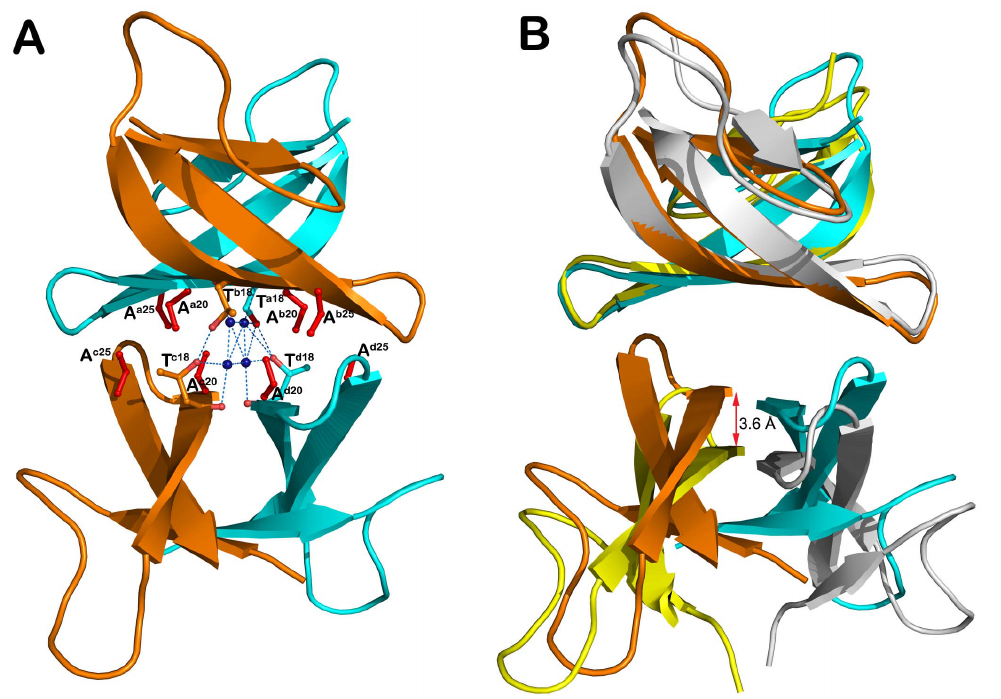
water-mediated H-bonds formed at the tetramer interface is shown as blue dashes. (B) Comparison of Y16A/I20A/L25A/F28A-HNP1 and wild type HNP1 tetramers. Tetramers were aligned based on AB dimers and colored cyan and orange (Y16A/I20A/L25A/F28A-HNP1) and yellow and grey (HNP1, PDB:3GNY, [27] ). The red arrow indicates the shift of the CD dimer of Y16A/I20A/L25A/F28A-HNP1 relative to the CD dimer of wild-type HNP1.